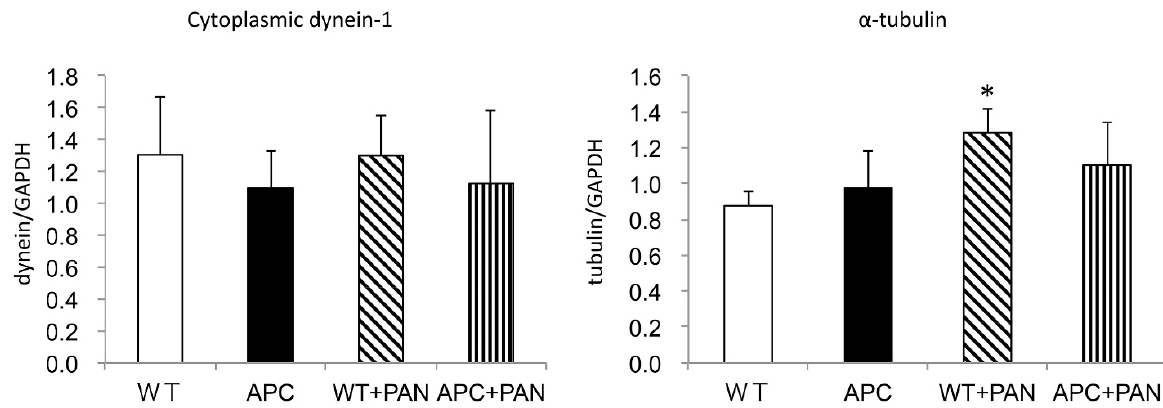
Figure 7. The mRNA expression of cytoplasmic dynein-1 and α -tubulin in the kidney of wild-type mice (WT), APC1638T mice (APC), and their PAN-induced nephrotic syndrome (WT+PAN, APC+PAN). n = 2 measurements from a mouse of WT and APC, n = 4 measurements from 3 mice of WT+PAN and APC+PAN. * p < 0.05 vs. WT.